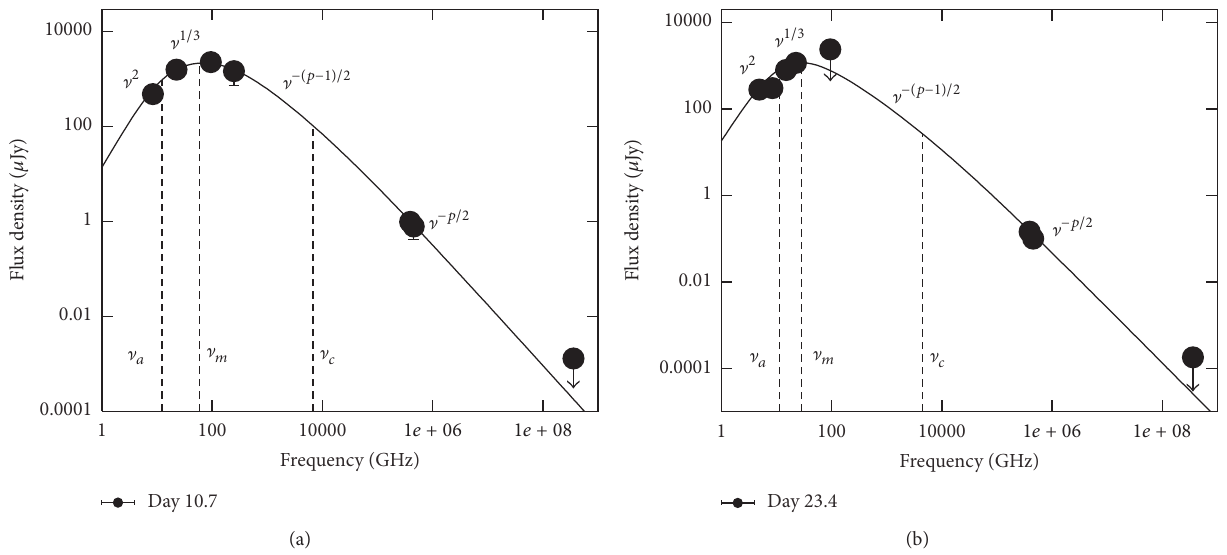
Figure 1: Multiwaveband spectra of GRB 070125 on day 10.7 and day 23.4. The spectra are in fast cooling regime. One can see that, between the spectra on day 10.7 and day 23.4, the peak has shifted to lower frequency. The figure is reproduced from Chandra et al.